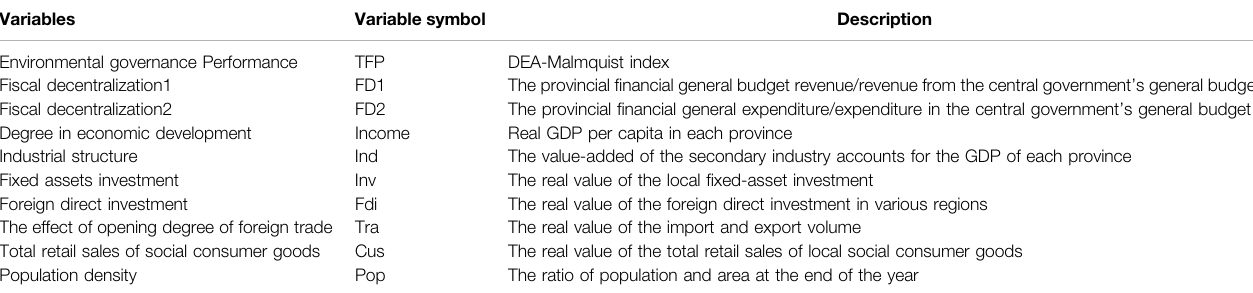
TABLE 2 | The descriptive statistics of variables. Variables Variable